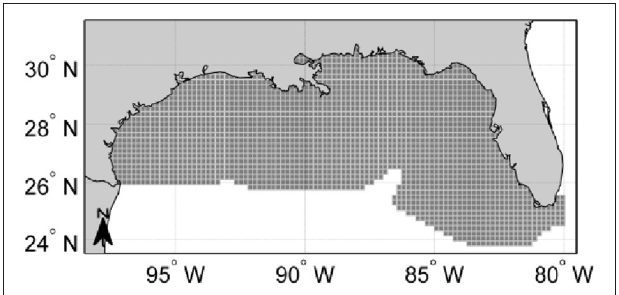
FIGURE 3 | Spatial grid (20 × 20km) for the U.S. Gulf of Mexico.